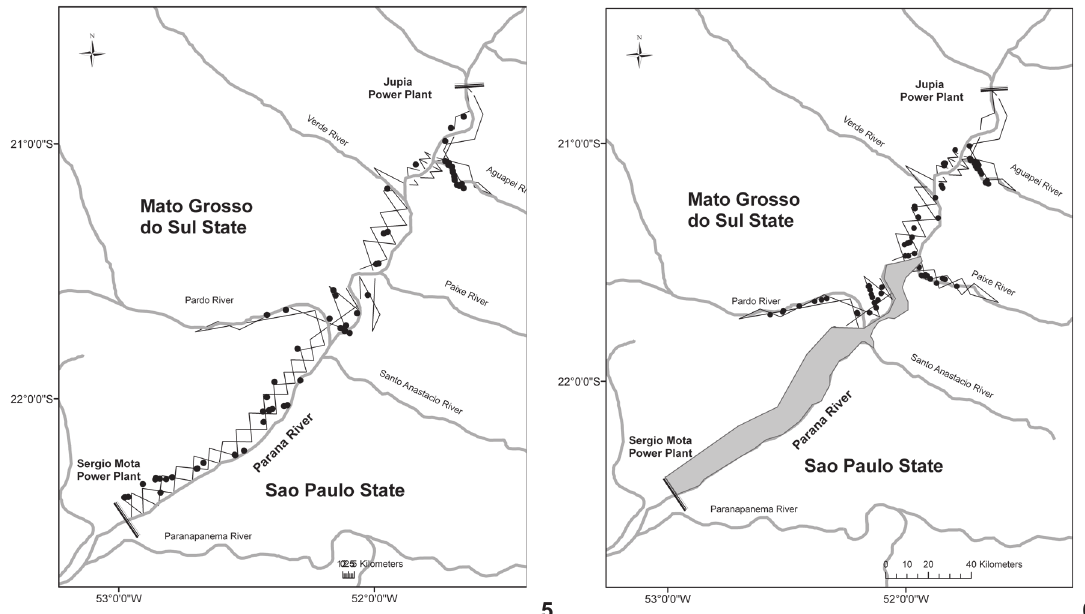
Figures 5-6. Marsh deer distribution in the Paraná River basin before flooding (5) and after flooding (6); deer are represented by black dots. The grey polygon indicates the area affected by lake